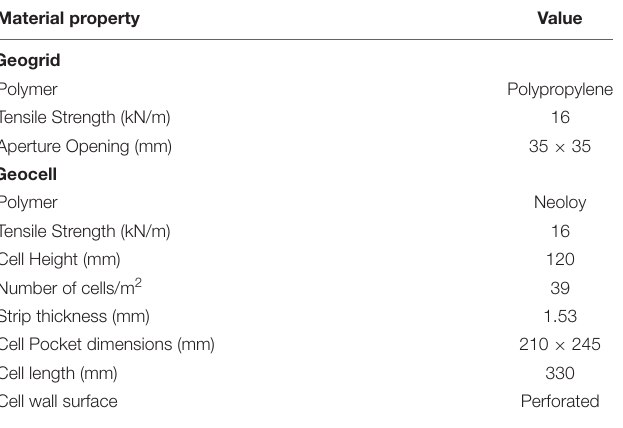
TABLE 1 | Mechanical and physical properties of geosynthetics.